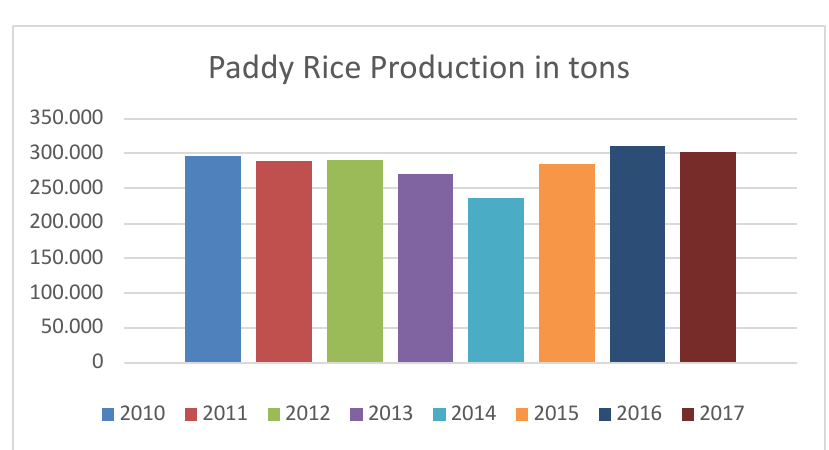
Figure 7 : Liberian Paddy Rice Production in tons (FAO/GIEWS,